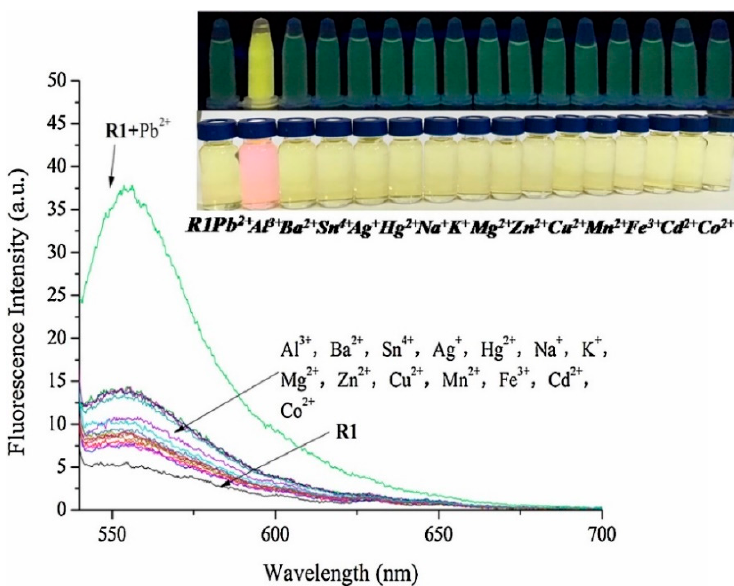
Figure 13. Fluorescence spectra of the probe based on rhodamine 6G and p-Cresol derivatives in the presence of Pb 2+ (1 × 10 –5 M) and other metal ion (5 × 10 –6 M). The inset shows the fluorescence under UV illumination and the color change of the probe upon the addition of Pb 2+ and other metal ions. Reprinted with permission from [190].